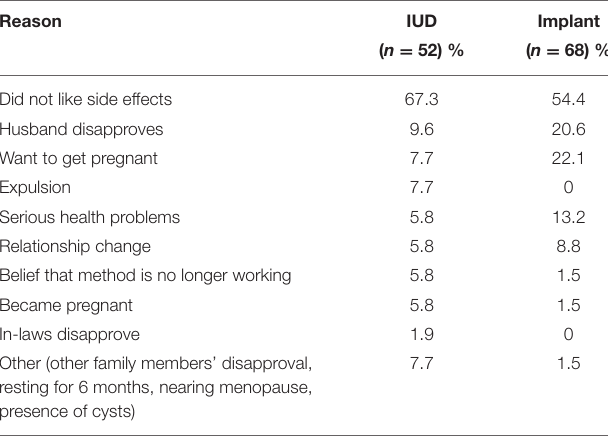
TABLE 4 | Percentage of women giving each reason for all-cause discontinuation, by method ( N =